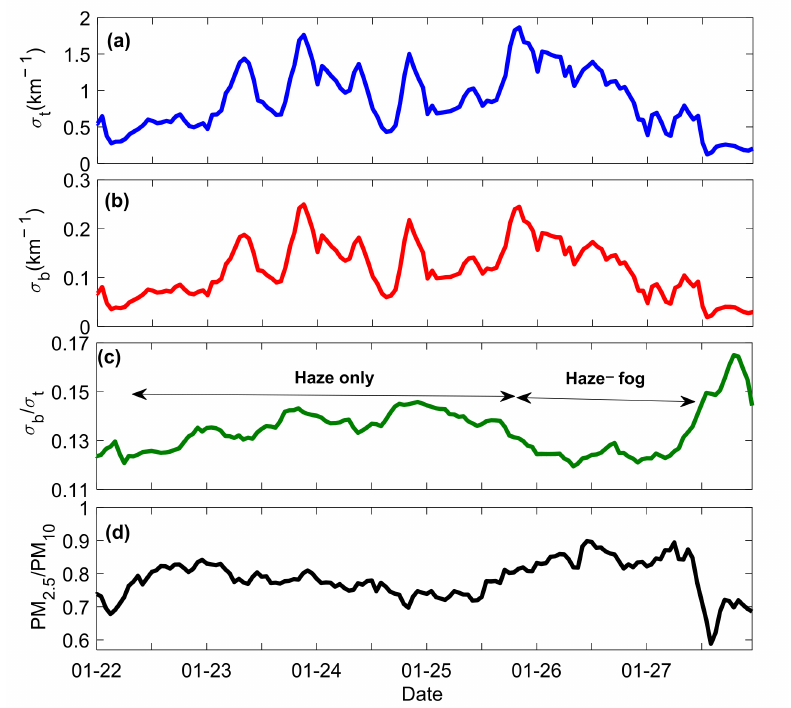
Figure 5. Variation in hourly mean ( a ) aerosol total scattering coefficient ( σ t ), ( b ) aerosol backward scattering coefficient ( σ b ), and ( c ) the ratio of σ b to σ t at 525 nm observed at the IAE station, and ( d ) the ratio of mass concentrations of PM 2.5 to PM 10 in Shenyang during 22–27 January